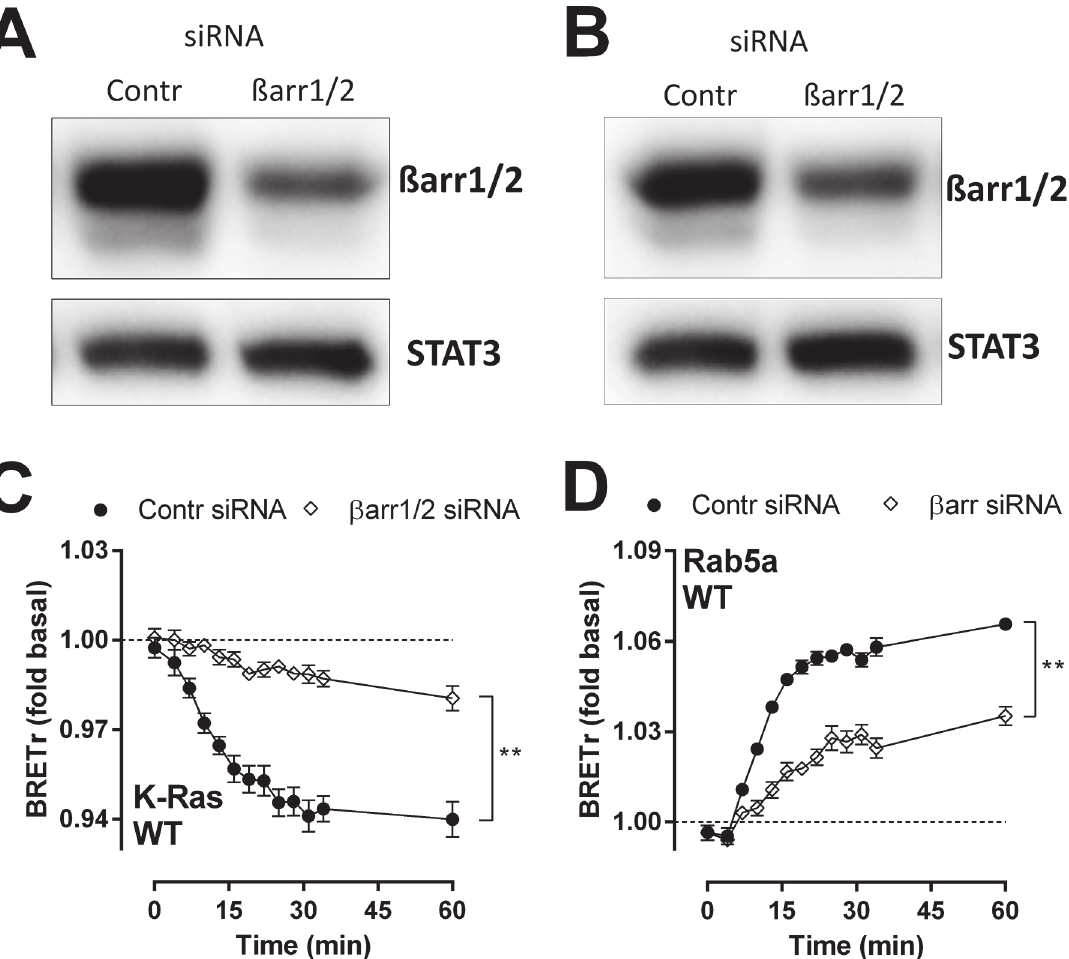
Fig 8. ORF74 trafficking is β -arrestin-dependent. HEK293T cells were transiently transfected with ORF74-Rluc8 and Venus-K-Ras (plasma membrane marker) (A, C) or Venus-Rab5a (early endosome marker) (B, D) in combination with control (Contr) or β -arrestin1/2 ( β arr1/2) siRNA. (A, B) Downregulation of β -arrestin1/2 levels was determined by immunoblotting. STAT3 levels were determined as loading control. (C, D) Cells were stimulated with CXCL1 for indicated time and BRET was measured. Data are shown as the mean of pooled data from three independent experiments each performed in triplicate. Data is presented as fold over vehicle-stimulated cells (dotted line) and error bars indicate SEM values. Statistical differences between the area under the curve of cells treated with control or β -arrestin1/2 siRNA (baseline = 1) were determined by a Student t test ( ** p (cid:1)